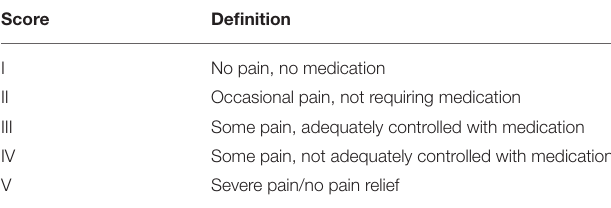
TABLE 1 | Barrow Neurological Institute (BNI) pain intensity scale